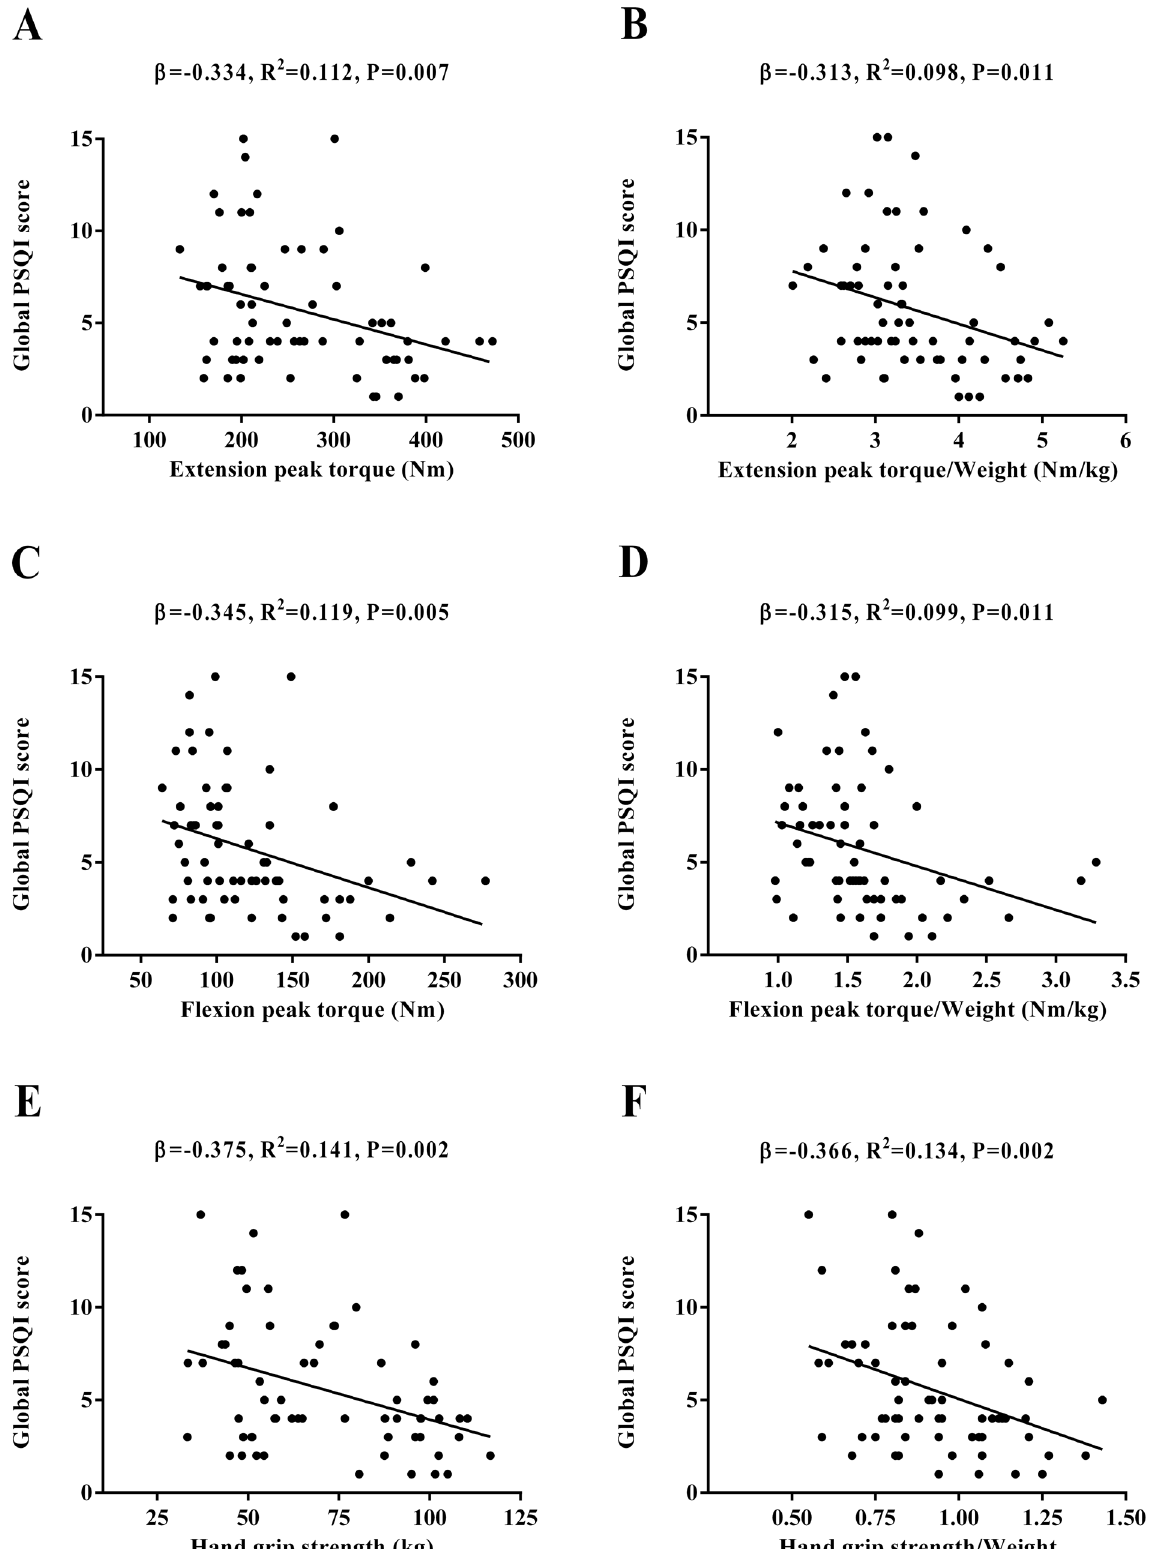
Figure 5. Association of muscular strength with subjective sleep quantity and quality in sedentary middle-aged adults. β (standardized regression coefficient), R 2 , and P from a simple linear regression analysis. Significant P values (≤ 0.05) are in bold. PSQI Pittsburgh Sleep Quality